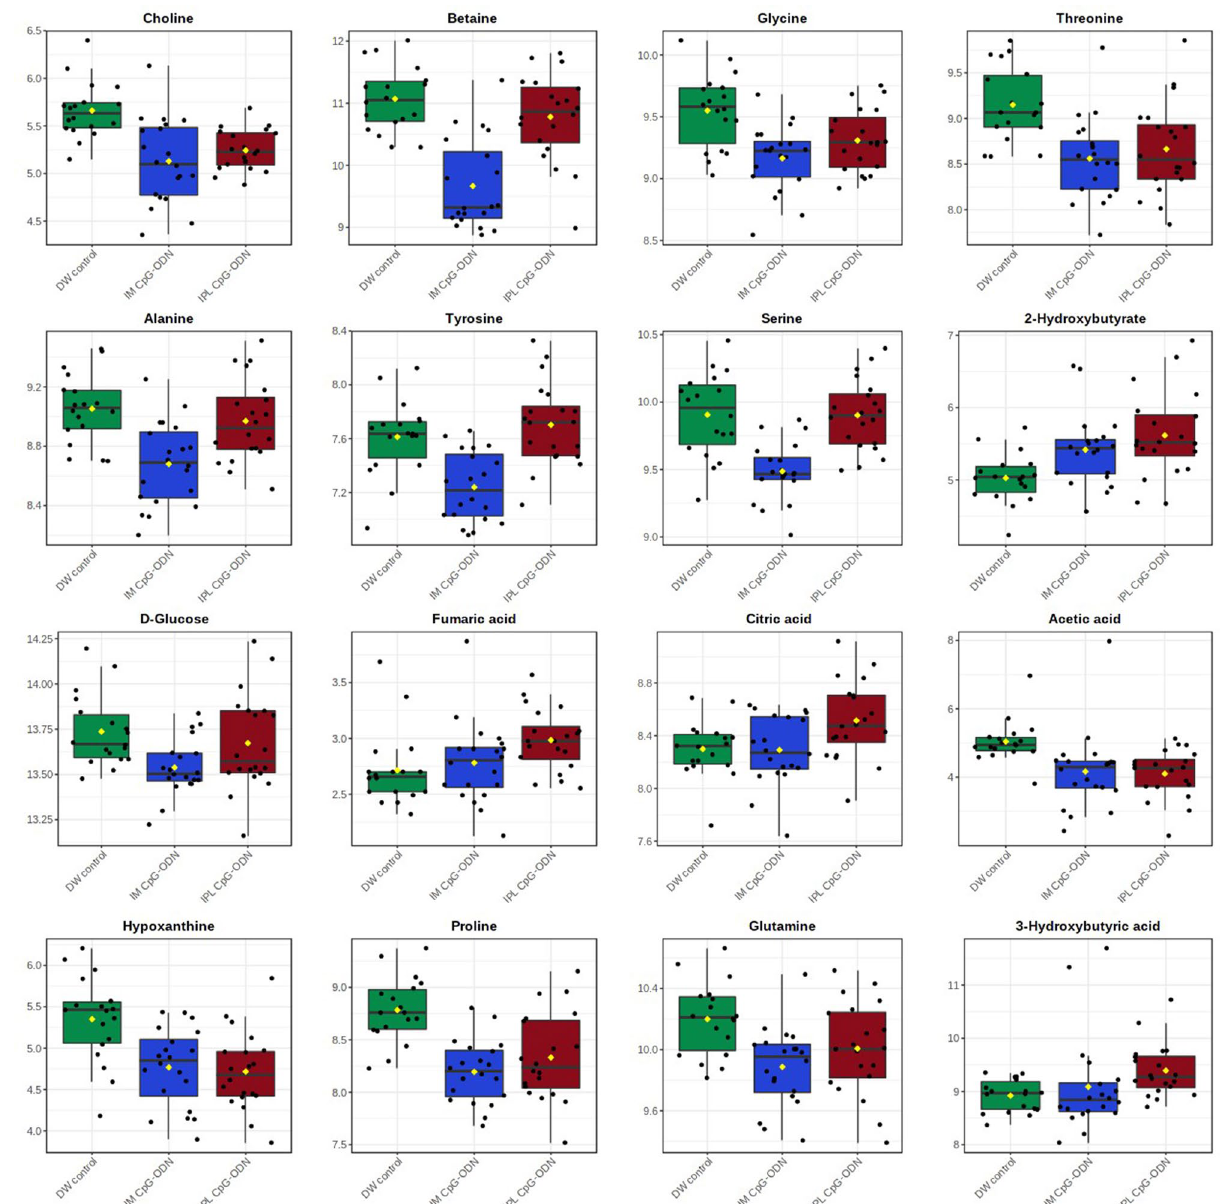
Figure 4. Combined box-and-whisker and dot plots showing the concentrations of selected metabolites in serum from neonatal chicks 24 h post-treatment. DW control, n = 18 (green); IM CpG-ODN, n = 20 (blue) and IPL CpG-ODN, n = 20 (red). Values are log-transformed concentrations in μM. One-way ANOVA results are detailed in supplementary Table